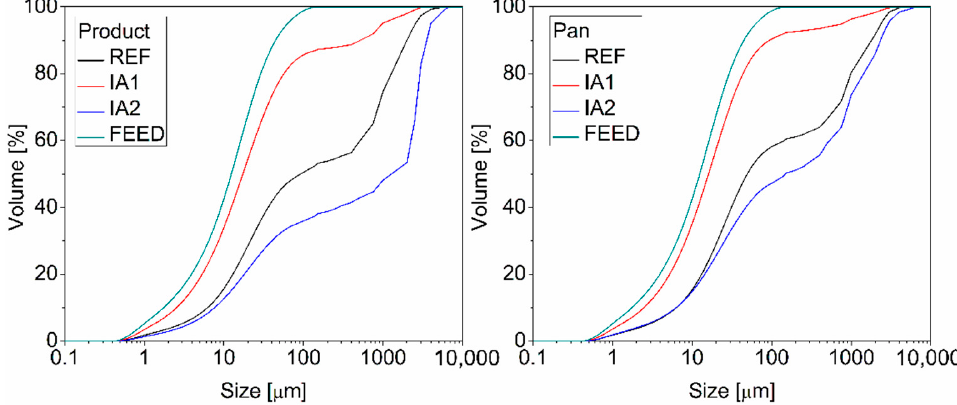
Figure 8. Influence of the binder content on PSD of product and pan samples of the granulation.